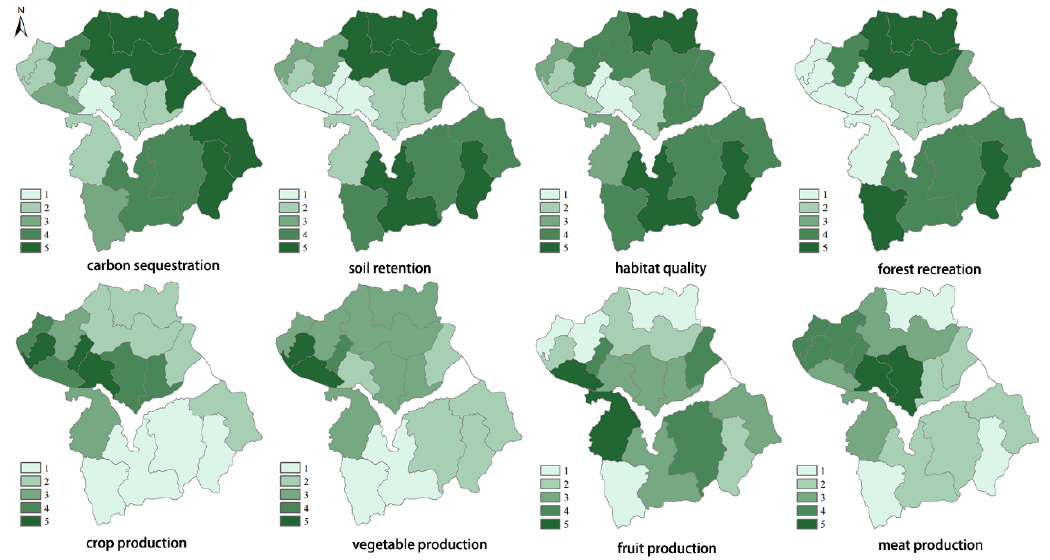
Figure 3. Spatial distribution of ecosystem services supply in Huailai county.